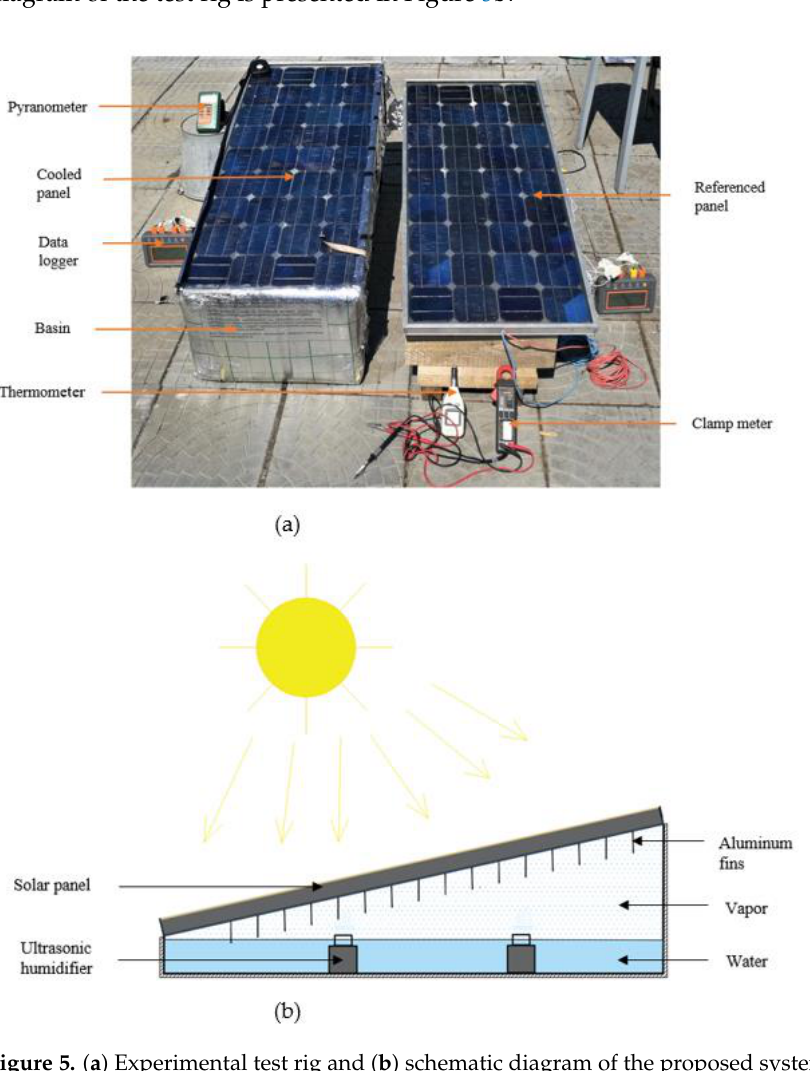
Figure 5. ( a ) Experimental test rig and ( b ) schematic diagram of the proposed system.